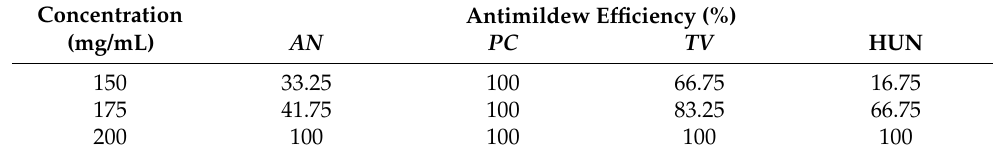
Table 3. Efficacy of different concentrations of citral on the mildew treatment of bamboo [11]. Concentration